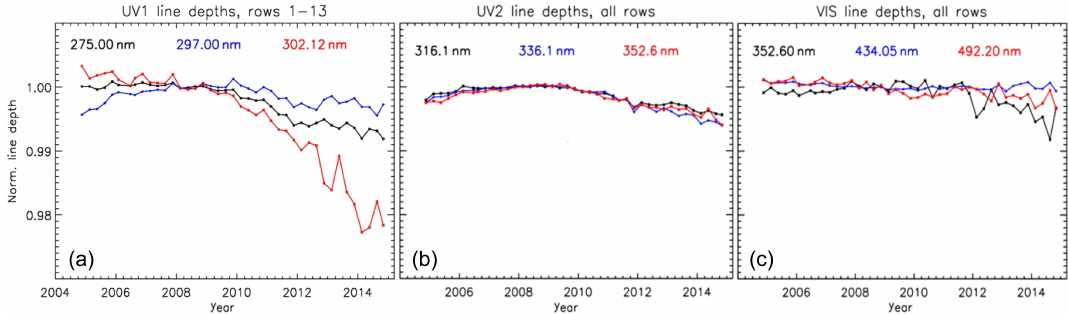
Figure 20. Changes in the normalized line depths of prominent absorption blends in the solar irradiances observed in UV1 (a) , UV2 (b) and VIS (c) .